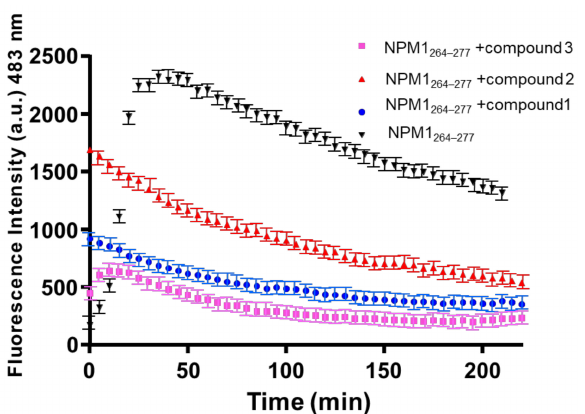
Figure 2. Overlay of time-courses of Thioflavin T (ThT) fluorescence emission intensity of nucleophosmin 1 (NPM1) 264–277 in presence of the three Ru(II) compounds ( 1 – 3 ), at 1:1 peptide to metal-based compound molar ratio. Results are representative of two independent experiments.